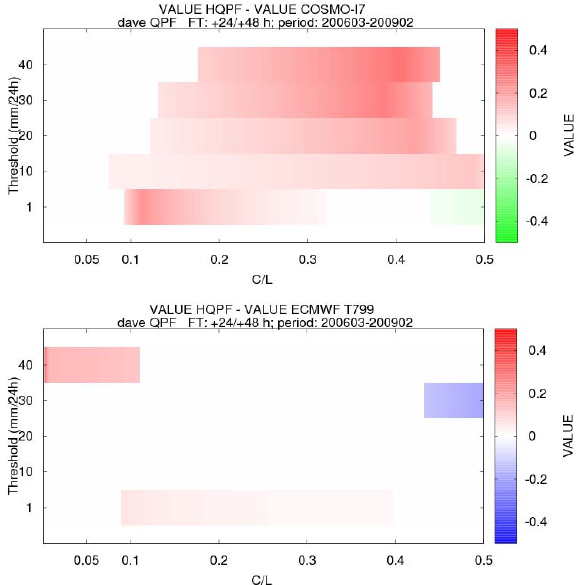
Fig. 4. Maps of the Value differences between HQPF and, respec- tively, COSMO-I7 (top) and IFS (bottom), for different thresholds and different C/L ratios, considering QPFA and the forecast time +24h/+48h. Note that only when the difference between HQPF Value and model QPF Value is statistically significant this differ- ence is plotted. The bar indicates that when there are positive values (red color), HQPF has more Value than the model.